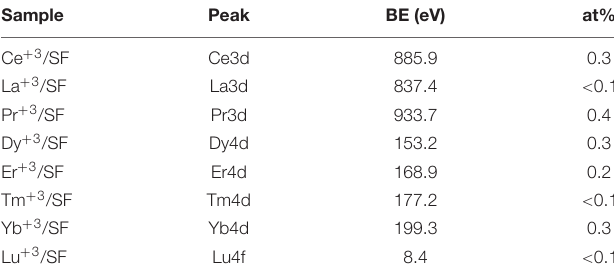
TABLE 3 | XPS peak analyses of Ln + 3 /SF